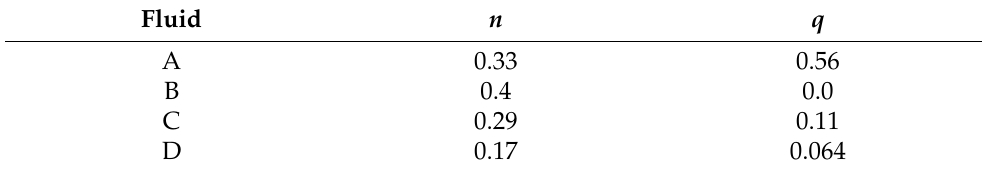
Table 1. Tabulated values of parameters for the WM model. Fluid A is polyisobutylene solution in decalin solvent [32]. The parameters for Fluid B are those fitted from a pseudo-Carreau Cross WM model to a low-density polyethylene melt [33]. Fluids C and D are polyethylene and polystyrene melts